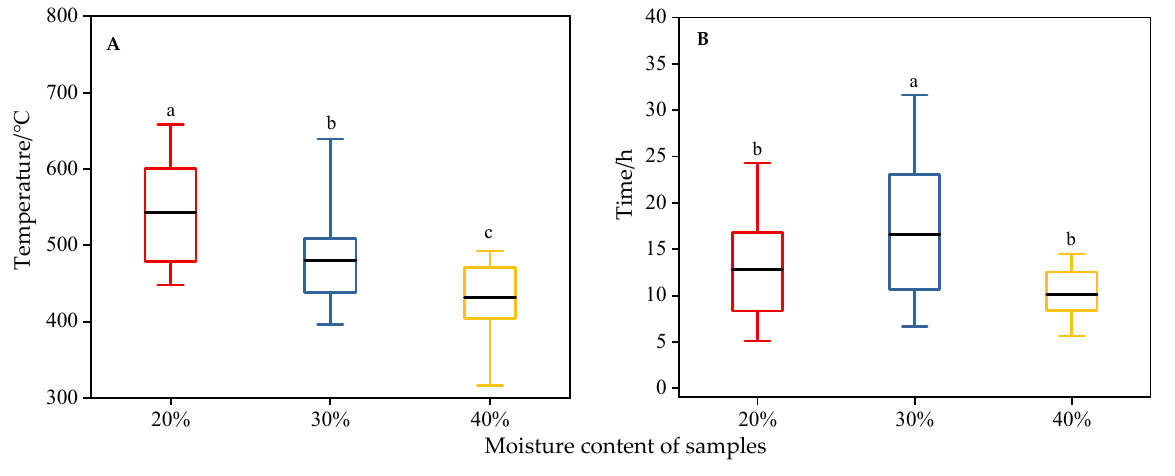
Figure 6. Variance analysis on influence of moisture content on temperature and combustion period during sub-surface fires (( A ): Effect of moisture content on peak temperature; ( B ): Effect of moisture content on time; a–c means that if there is any same lowercase letter, the difference is not significant). The highest temperature varied greatly at different depths, with the average highest temperature at a depth of 18 cm, which also was the lowest depth recorded (Figure 7A). The humus in deeper layers took the longest time to reach the peak temperature (27 cm), and there was little difference between the combustion times at the depths of 12–18 cm.